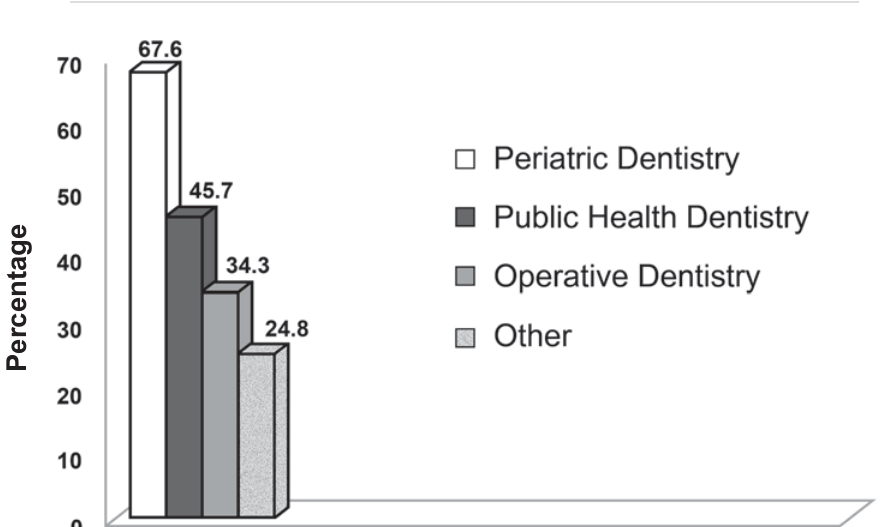
FIGURE 4- Distribution of the responses to the question “As part of which discipline has ART been